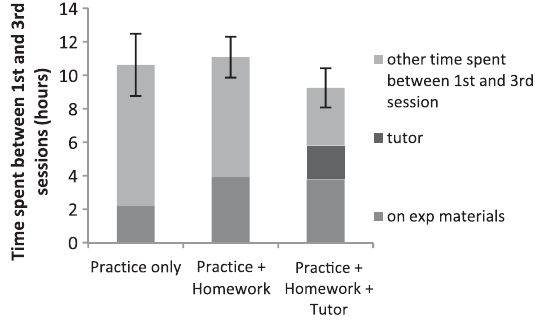
FIG. 8. Self-report on time spent between the first and third